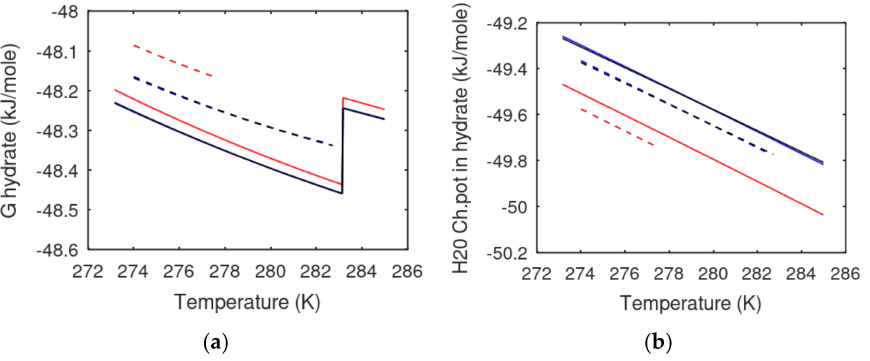
Figure 6. ( a ) Gibbs free energies for CO 2 hydrates formed heterogeneously on gas/liquid interface (solid curves) and Gibbs free energies for CO 2 hydrates formed homogeneously (dashed curves) at 50 bar and up to stability limit in concentration. Hydrates formed from pure water are in black, hydrates formed from average seawater (mole-fraction NaCl equal to 0.0108) are in blue, and hydrates formed from water containing 0.0394 mole-fraction NaCl are in red. ( b ) Calculated water chemical potentials for the same conditions and content of NaCl as in ( a ).